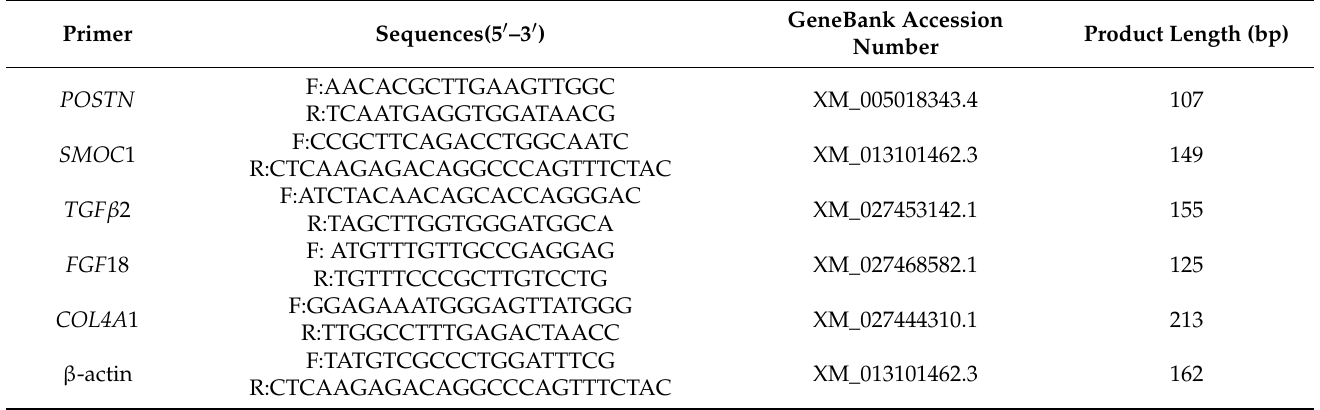
Table 2. qPCR primers of Muscovy